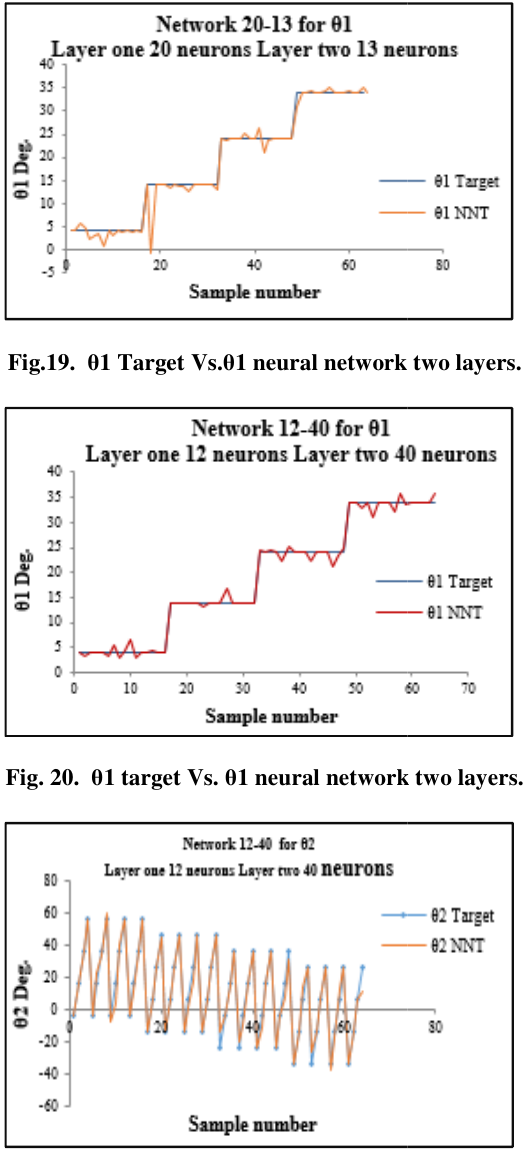
Fig. 21. θ 2 target Vs. θ 2 neural network two layers